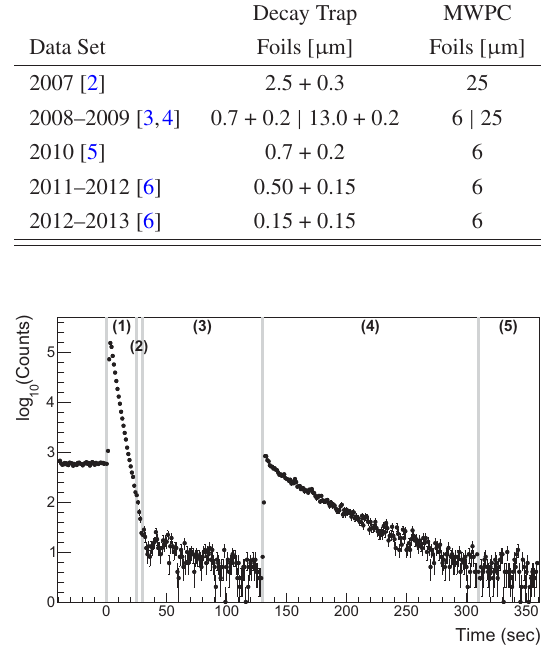
Figure 2. Counts in the UCN detector during the depolarization measurement. See text for details.